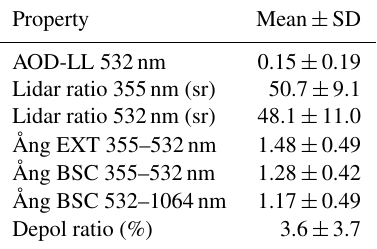
Table 2. Summary of lidar mean optical properties for the lofted aerosol layers measured over the PRD